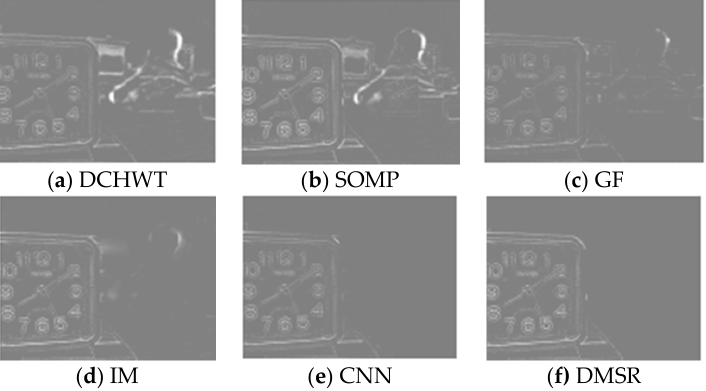
Figure 9. Normalized di ff erence images between each of the fused images and Figure 8b. Another example, the fusion results of the “Flowerpot” image pair (944 × 736) are shown in Figure 10c–h. The normalized difference images between the correctly focused source image and the fusion results are shown in Figure 11. Similar to the previous example, the DCHWT and SOMP method produced serious artifacts around the “horologe”. The fused image obtained by the GF method suffered from a ringing effect, and the edges of the “horologe” were blurred. The results of the IM method also showed similar artifacts near the “horologe”. Although the CNN method image. Comparatively, the DMSR method exhibited the best visual quality. ( a ) Left focus ( h ) DMSR Figure 10. The “Flowerpot” source images and fusion results obtained by different fusion methods.